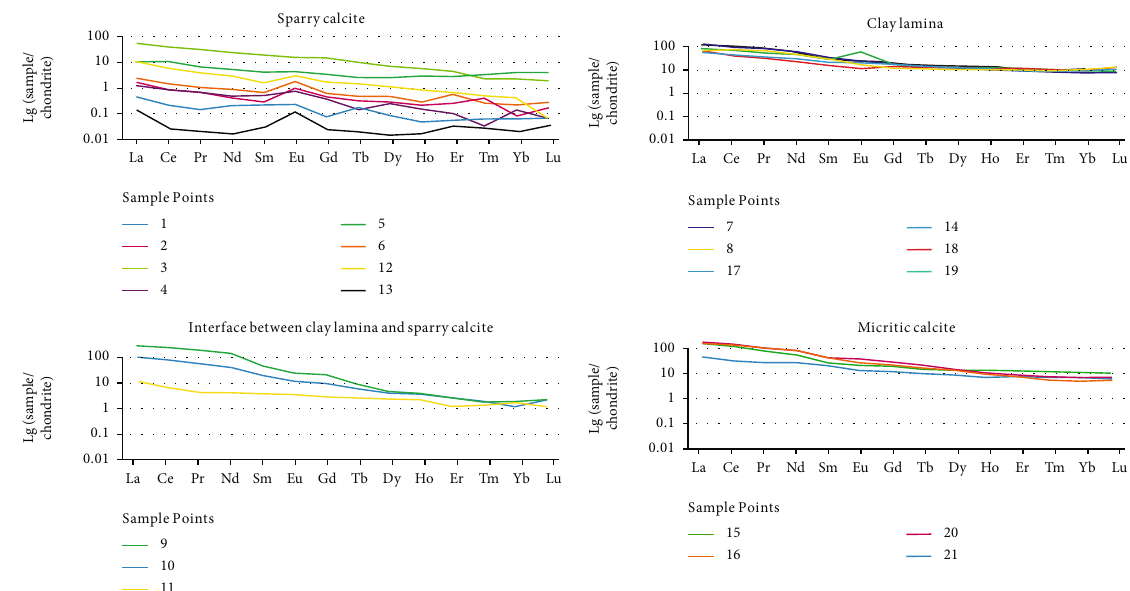
Figure 10: Standardized data of laminated argillaceous sparry limestone